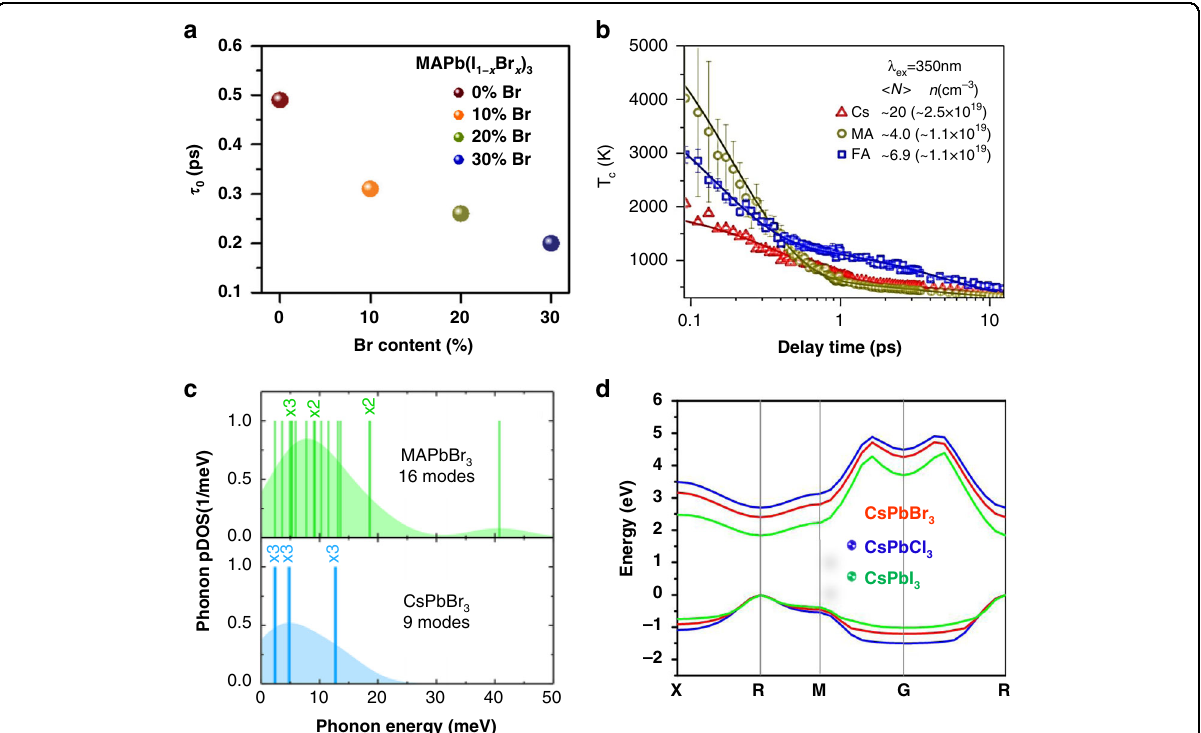
Fig. 10 Effect of chemical modi fi cations on HC relaxation dynamics in organic – inorganic lead halide perovskite. a The rapid thermalization of HC with increasing Br concentration can be seen, which indicates the strong electron – phonon coupling that in fact reduces the phonon bottleneck effect. b The dependence of HC cooling on cation nature where FA and MA cations are more prone to charge carrier – phonon coupling compared to Cs counterpart. c Energy and density of states of phonons in MAPbBr 3 (16 modes) and CsPbBr 3 (9 modes) and d the band structure of all inorganic perovskite (CsPbX 3 , X = Cl, Br, I) crystal showing the highest valence band (VB1) and lowest conduction band (CB1) and their energy of states. The fi gures are taken with the permission from ( a ) ref. 54 , ( b ) ref. 47 , ( c ) ref. 58 , and ( d ) ref.